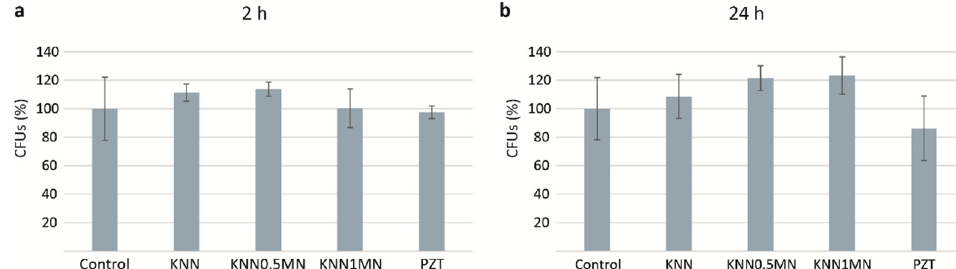
Figure 9. Determination of S. cerevisiae cells CFUs after exposure to 1000 μ g/mL of KNN, KNN- 0.5MN, KNN-1MN, and PZT, for 2 h ( a ) and 24 h ( b ). “Control” corresponds to non-exposed